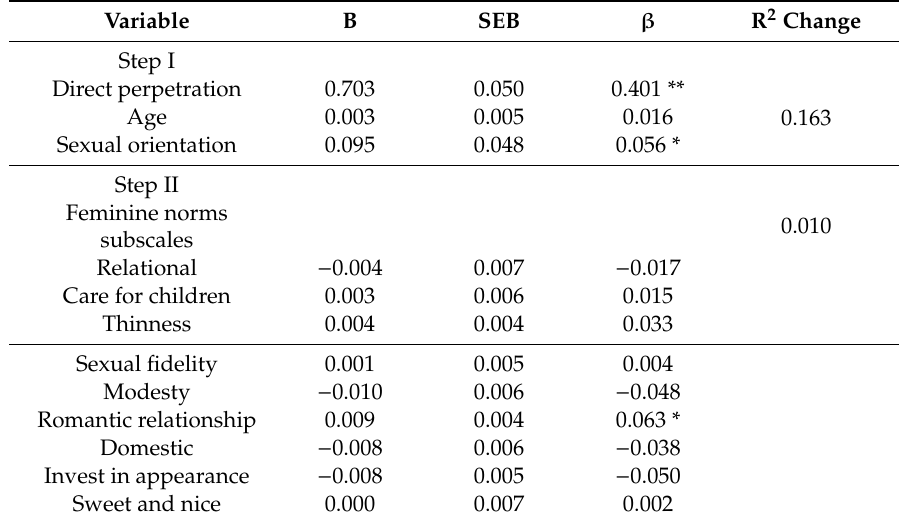
Table 3. Hierarchical regression analysis analyzing the association between feminine norms and direct cyber dating